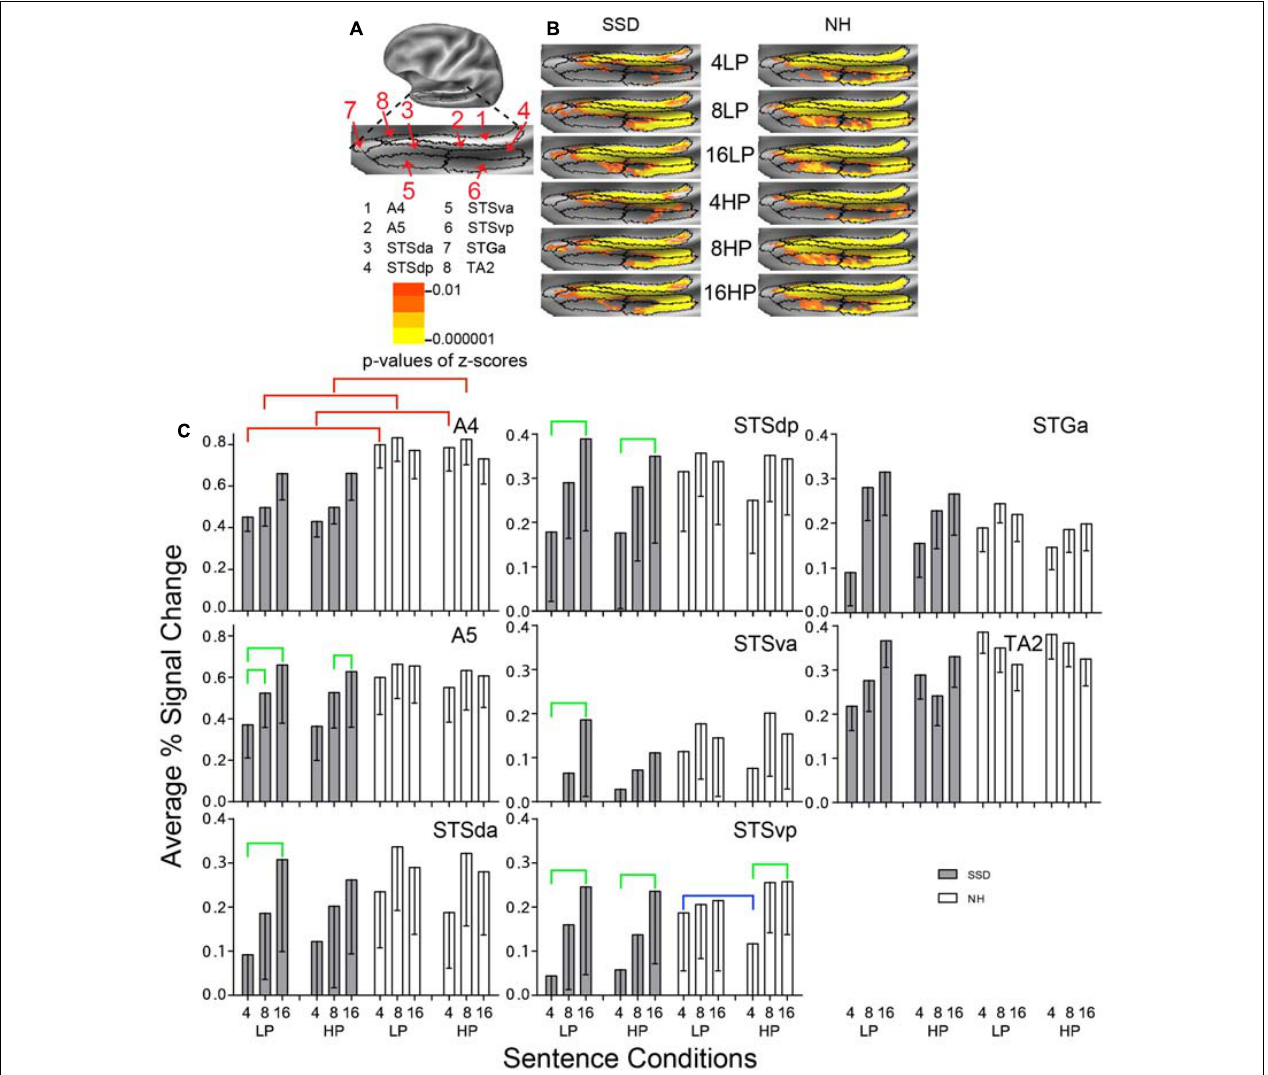
FIGURE 4 | Results from eight parcels in the LH Auditory Association Cortex (AAC) region. (A) Lateral view of a partially inflated left hemisphere slightly rotated inferior. (B) Enlarged views of parcels with clusters scaled as in Figure 3 . (C) A4 had significant group effects marked with red brackets. A5, STSda, STSdp, STSva, and STSvp had significant intelligibility effects marked with green brackets. STSvp had a significant predictability effect marked by a blue